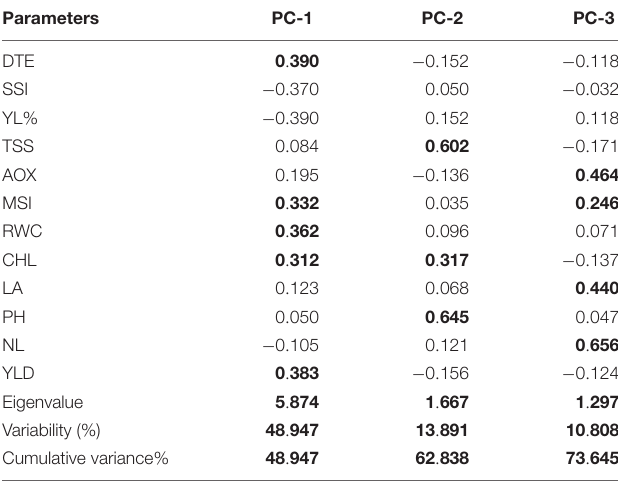
TABLE 10 | Rotated component matrix for the principal components of 12 traits of 100 onion genotypes evaluated under drought stress.